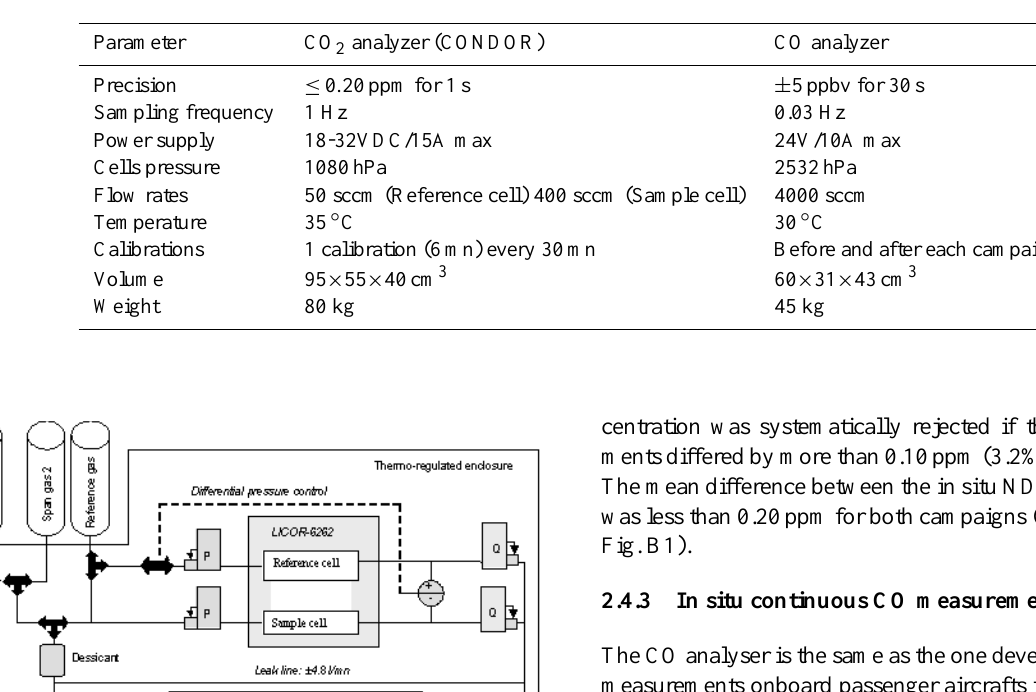
Table 4. Characteristics of the CO 2 and CO analyzers.